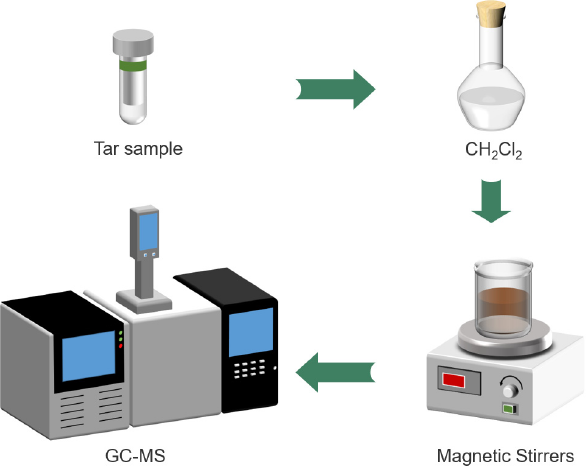
Figure 2. Processing and analysis of tar sample.